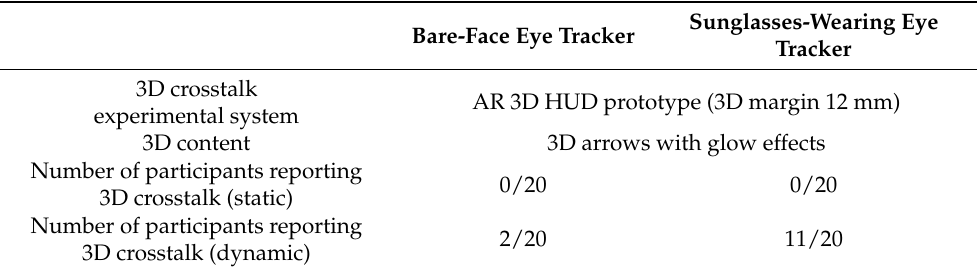
Table 2. Experimental results for 3D crosstalk with the proposed eye-tracking algorithms for bare and sunglasses-wearing faces. All experiments were performed using a commercial embedded system with an AR 3D HUD